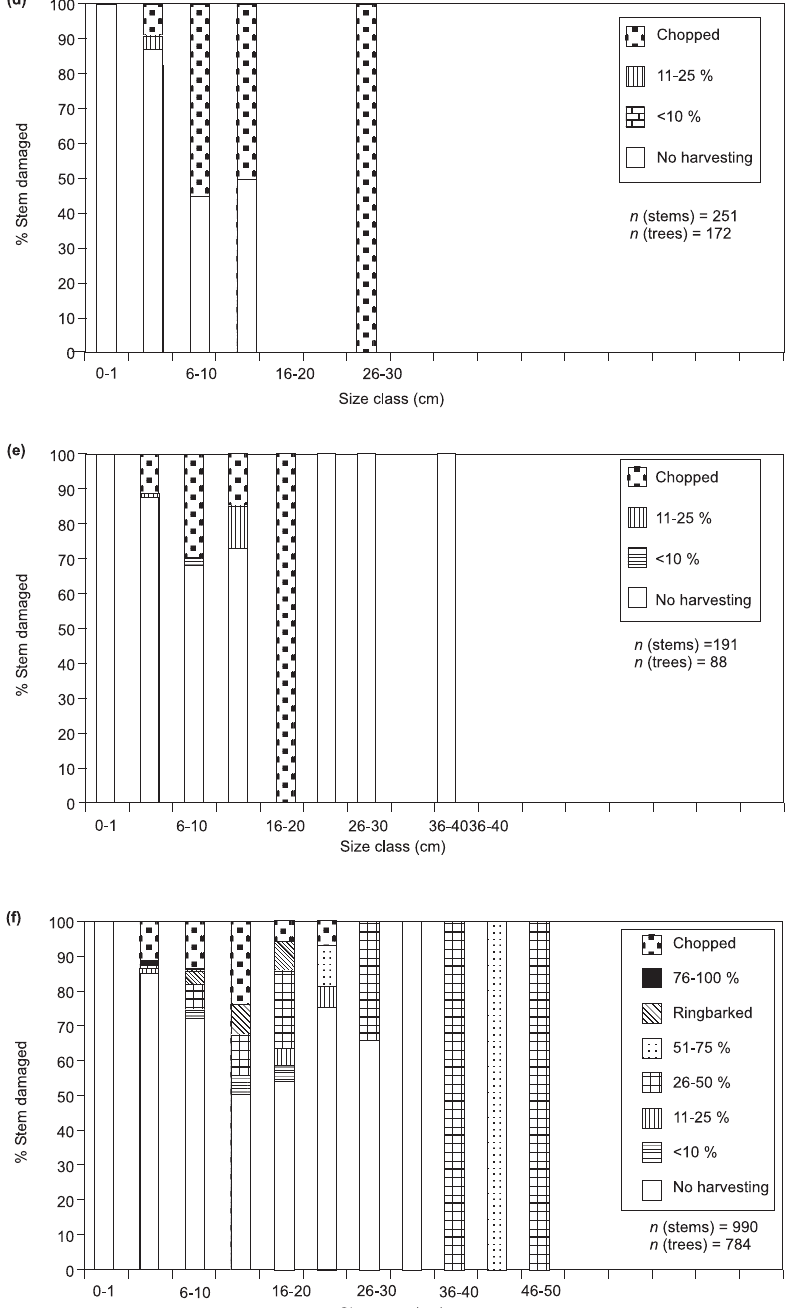
Fig. 4(d-f). Degree of stem damage to harvested Catha edulis through harvesting of bark below 2 m on the stem, and chopping of stems in populations situated (d) on communal land in Nsikazi; (e) on the roadside near Hazyview and (f) pooled